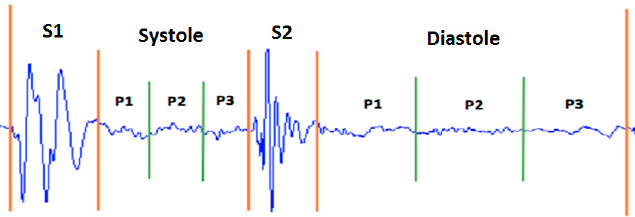
Figure 6. Distribution of power features for a normal heart sound.